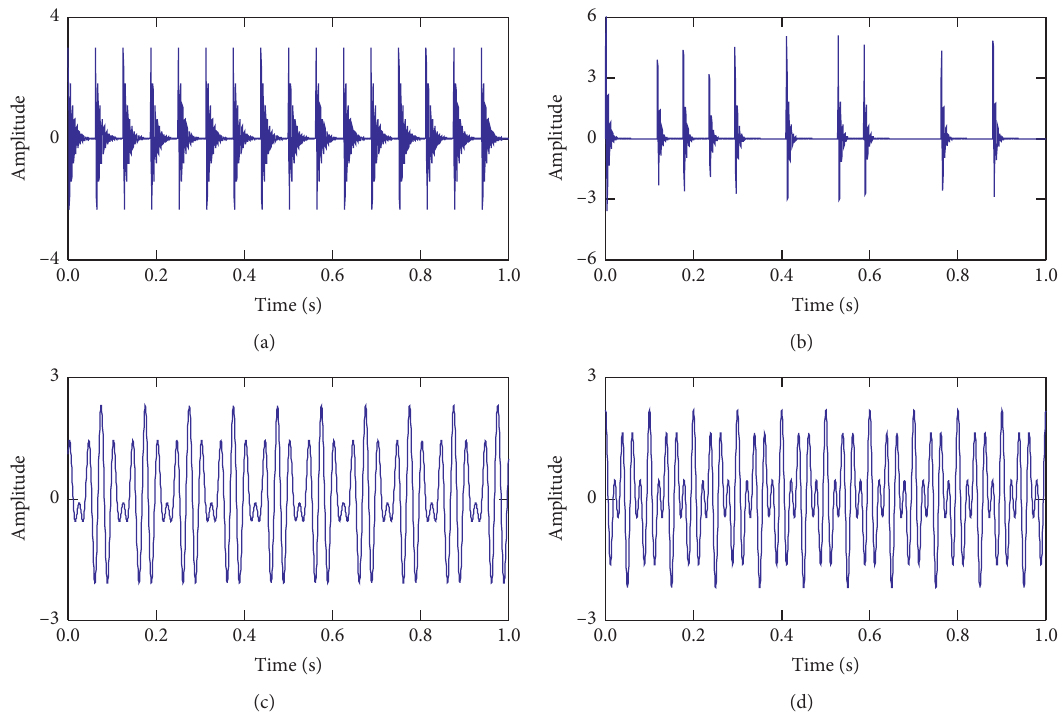
Figure 10: (a) Impulsive signal y 1 ( t ), (b) random impulsive signal y 2 ( t ), (c) harmonic signal y 3 ( t ), and (d) harmonic signal y 4 ( t ).